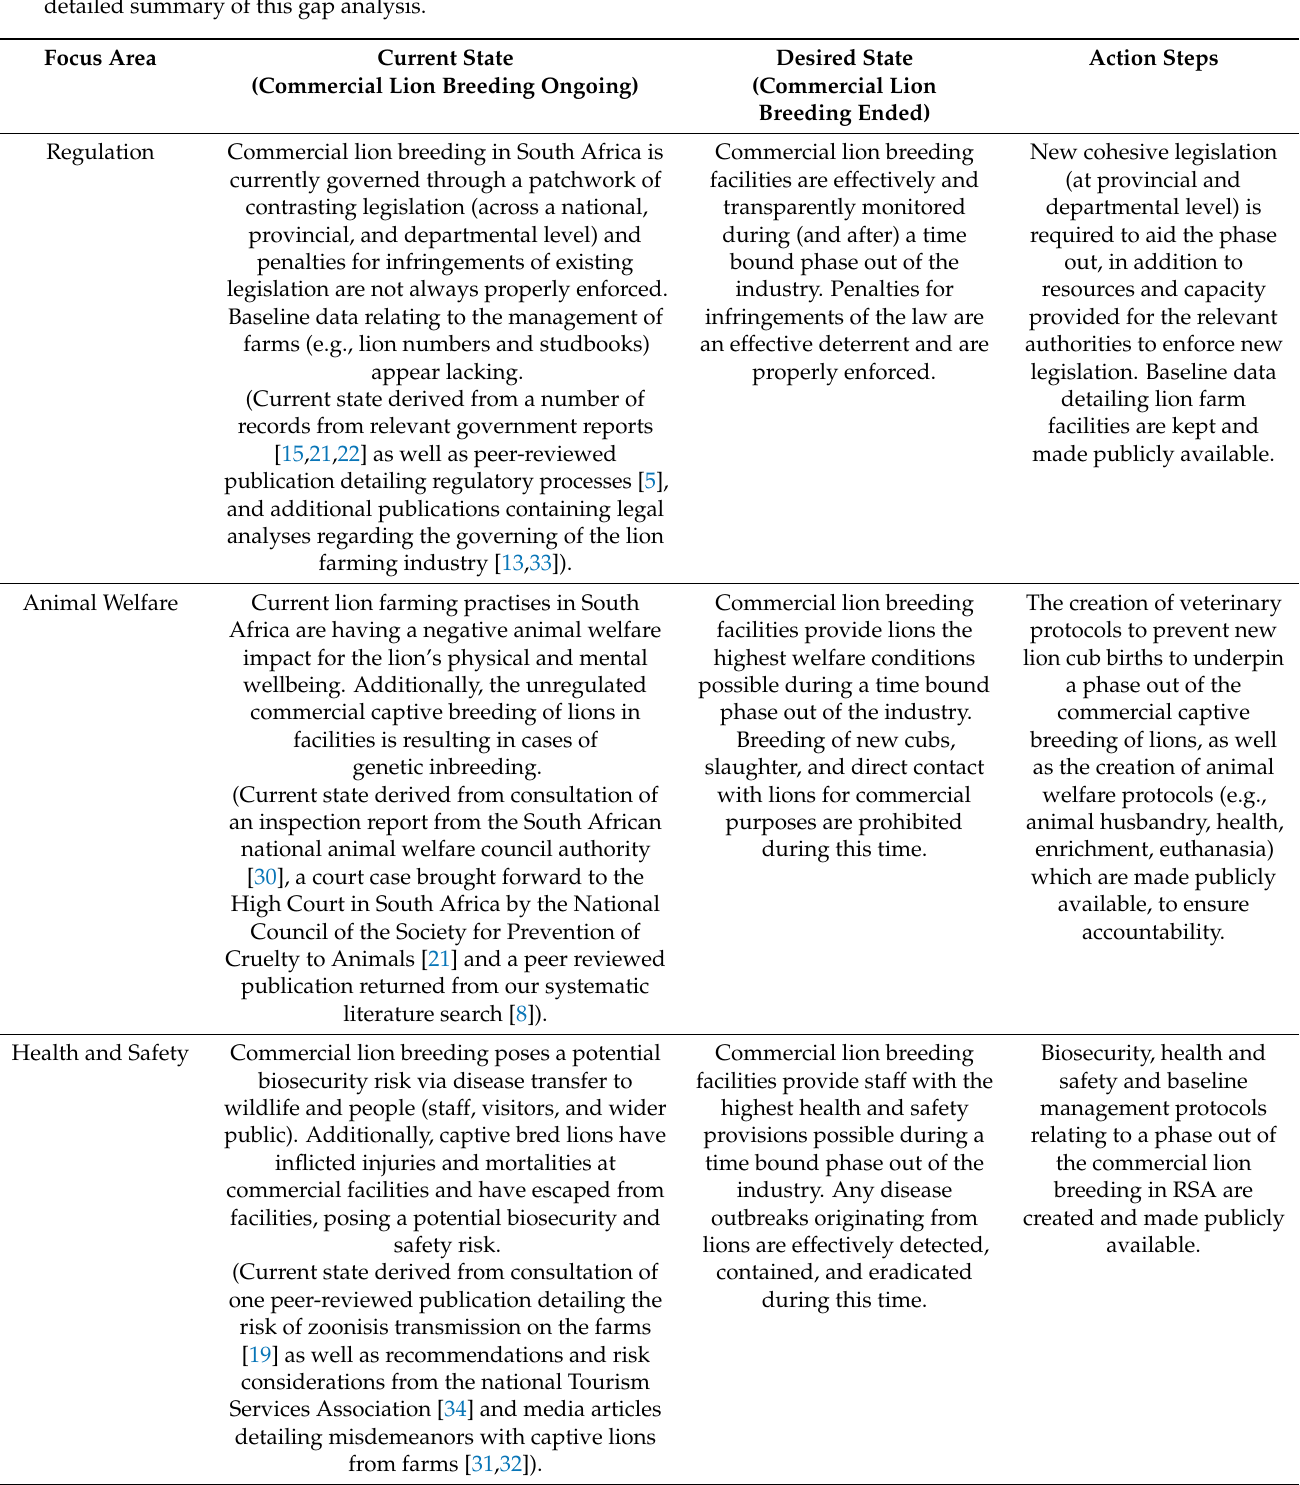
Table 1. Gap analysis table summarising five focus areas for consideration (regulation, animal welfare, health and safety, equitability, and conservation). Based on background literature and discussions with a team of eight researchers, the table also summarises the identified ‘current state’ (management issues associated with the present industry), the suggested ‘desired state’ (the perceived ideal management of an industry phase out) and proposed action steps (specific actions that could facilitate the transition between current state and desired state) for each focus area. See Appendix C for a more detailed summary of this gap